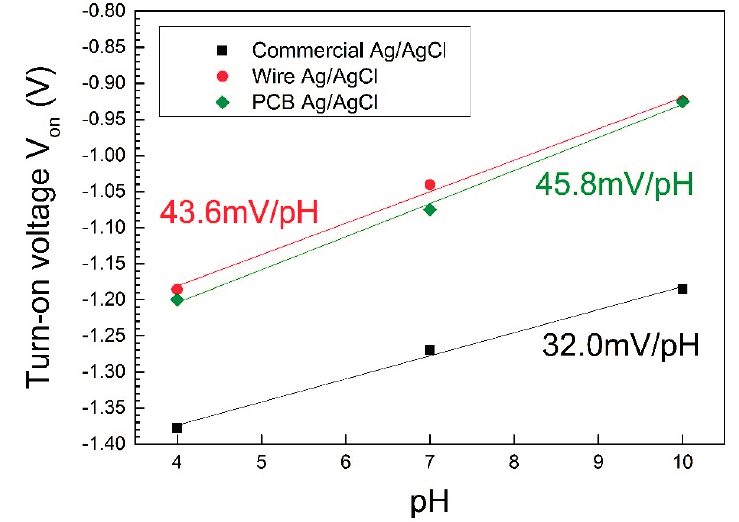
Figure 10. ITO PCB (Indium Tin Oxide Printed Circuit Board) sensor pH sensitivity (turn-on voltage V on shift) for different types of reference electrodes (commercial, wire,